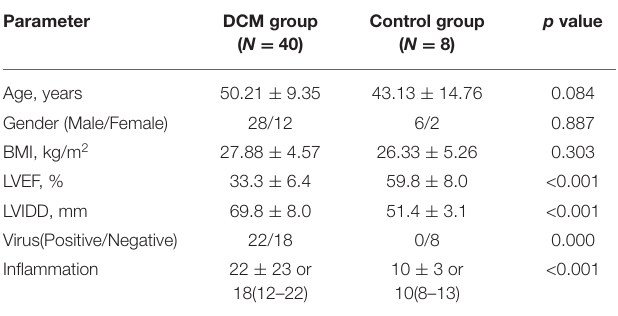
TABLE 2 | The clinical characteristics of GSE17800 in dilated cardiomyopathy.